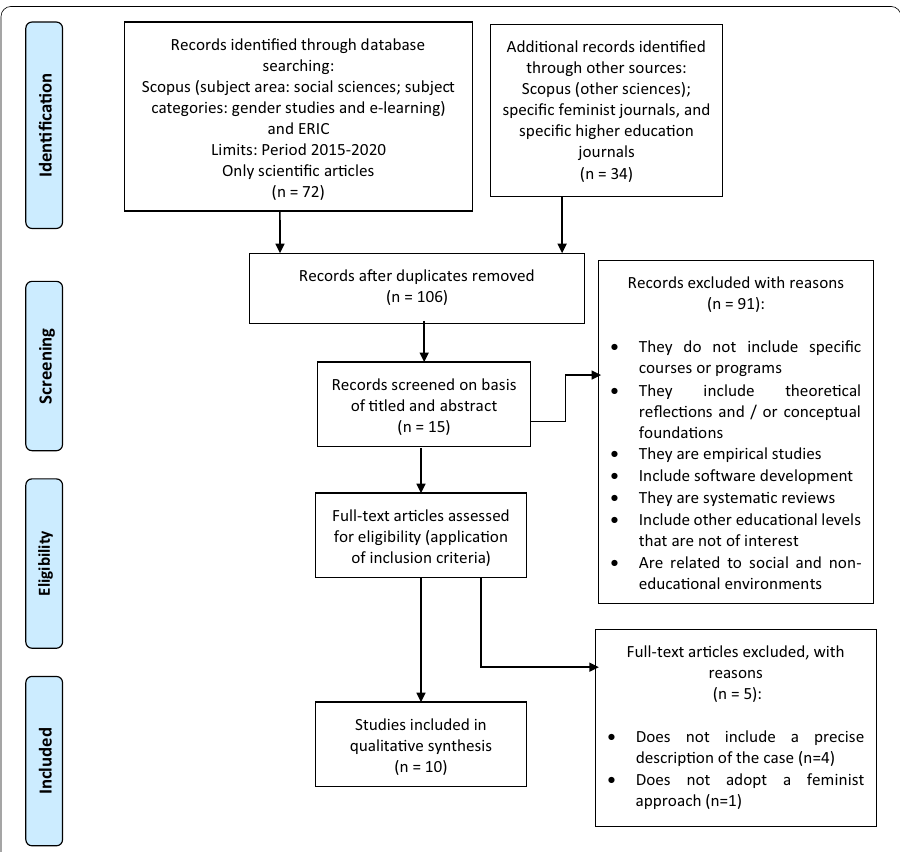
Fig. 1 Review PRISMA flow chart (modified after Moher et al., 2009, p. 8) and based on recommendations for Peters et al., (2020a, 2020b, p. 2125) for scoping